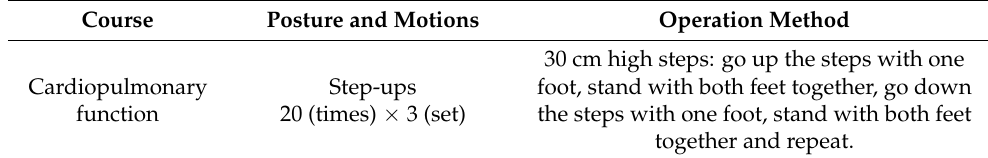
Table 2. Moderately strenuous physical activity